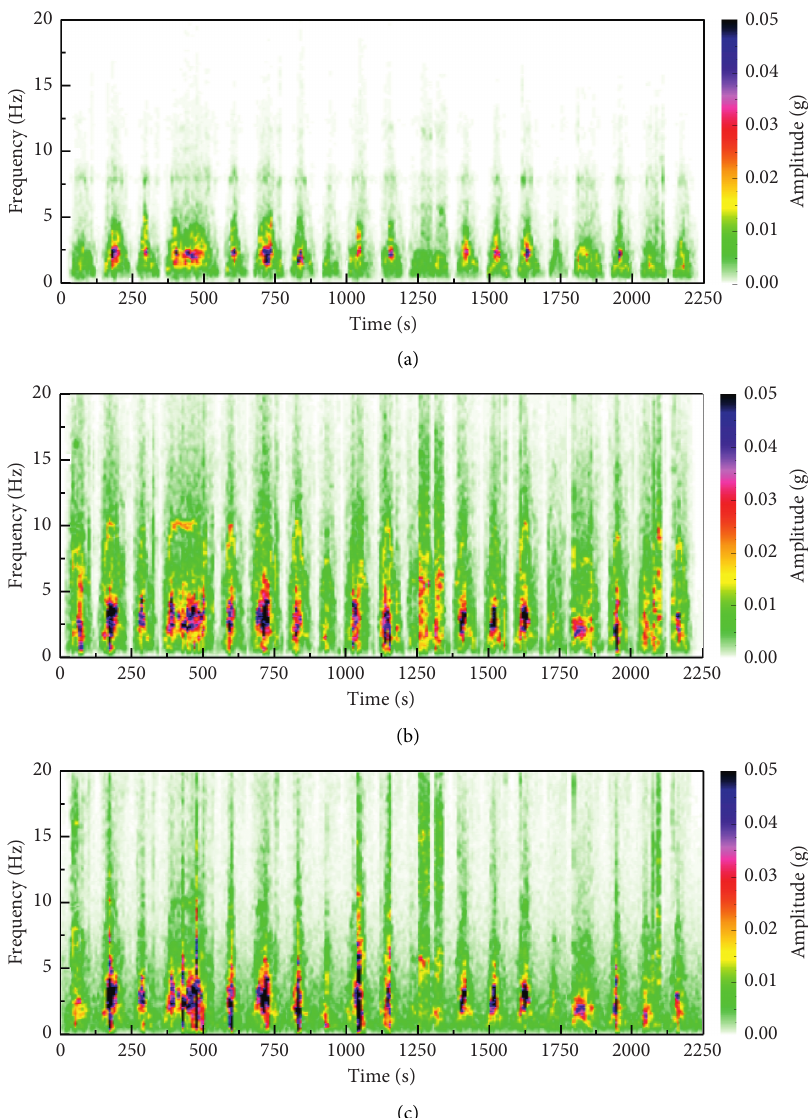
Figure 2: Time-frequency analysis of lateral vibration acceleration on carbody, frame, and axlebox (All). (a) Left side on carbody above the first bogie. (b) Left side on frame-end of the first bogie (Frame-end_1L). (c) Left axlebox of first axle (Axlebox_1L).